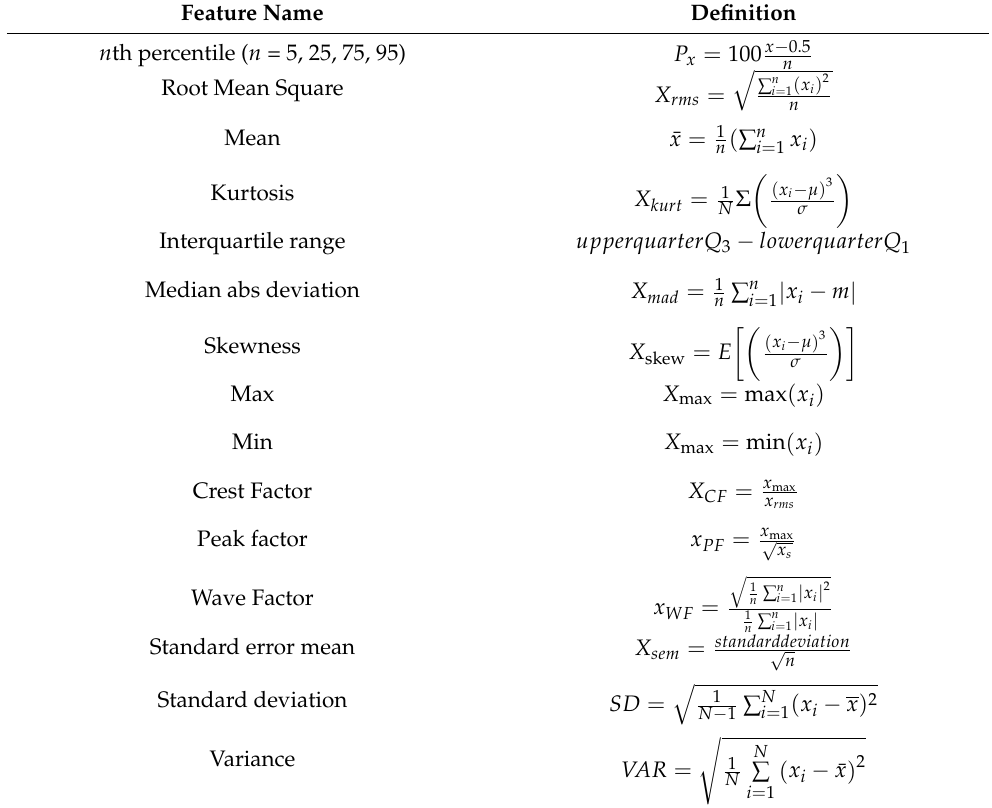
Table 2. Statistical Extracted Features and their definitions